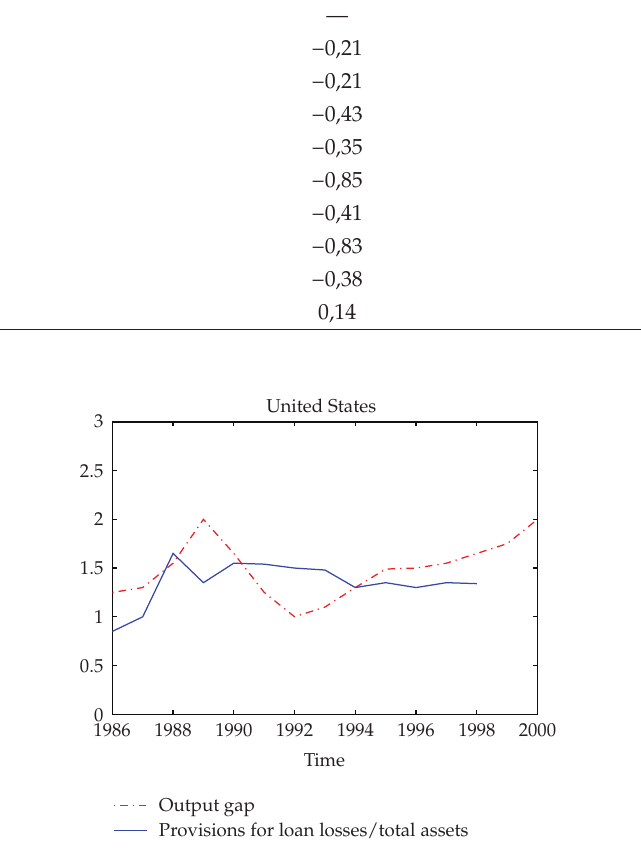
Figure 5: Output gap versus provisions for loan losses-to-total assets ratio for the United States (cid:2) 1986– 2000 (cid:3)